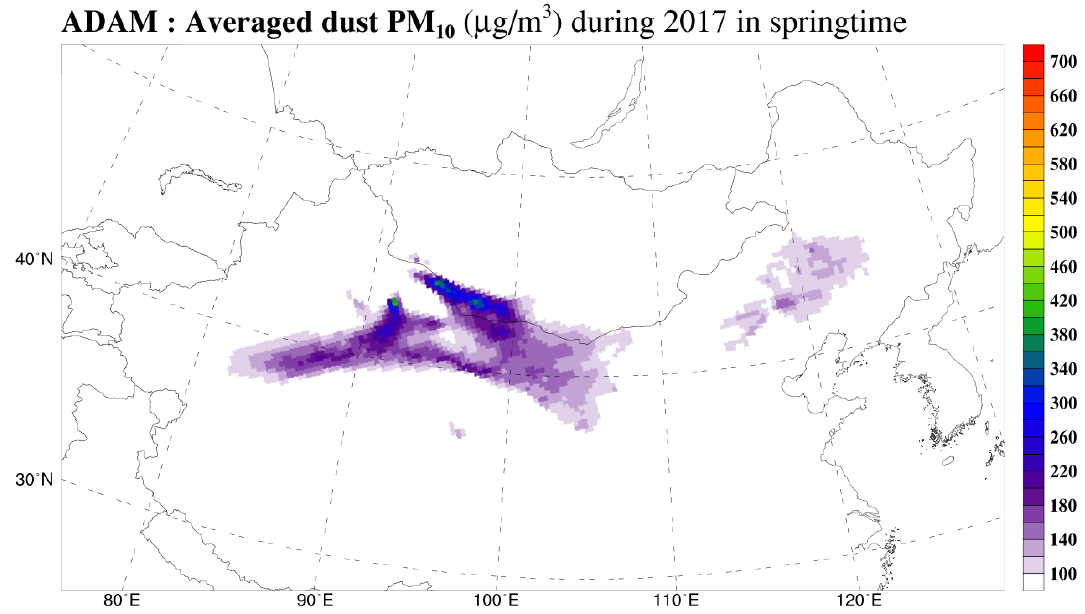
Figure 5. The distribution of mean dust PM 10 mass concentrations simulated by ADAM (from March 1 to May 31, 2017). Units: µg m −3 .